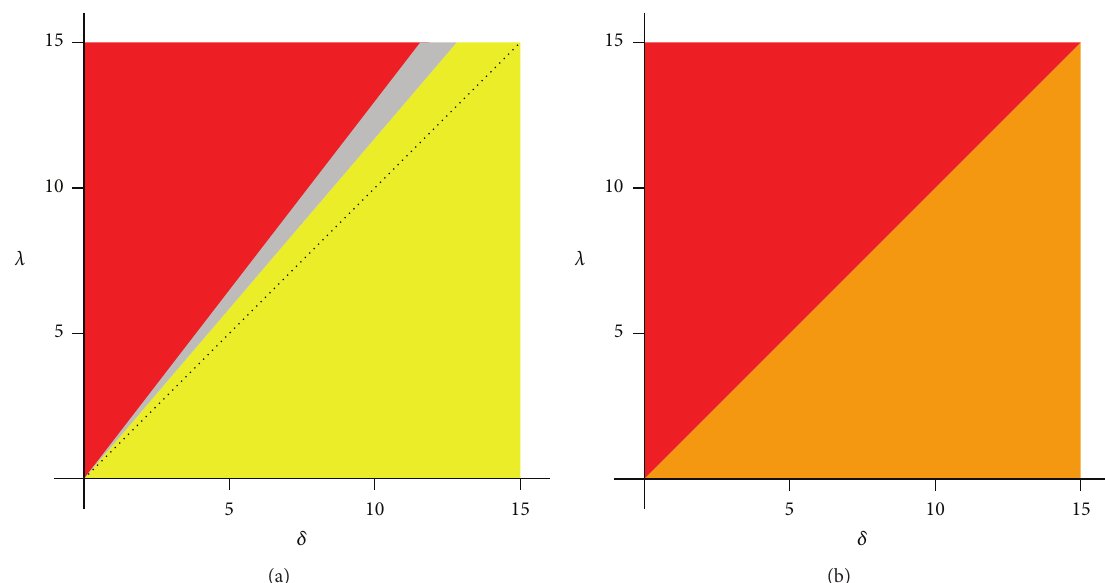
Figure 4: Possible epidemic outcomes. Yellow: disease-free. Orange: endemic primary infection. Gray: disease-free or endemic coinfection depending on initial values. Red: endemic coinfection. (a) Parameter values: 𝑎 𝑈 = 0 . 9 , 𝑎 𝑉 = 0 . 7 , 𝑟 = 26 , 𝑚 = 12 , 𝜇 𝑈 = 0 . 3 , 𝜇 𝑉 = 0 . 5 , 𝑐 𝑆𝑆 = 3 . 8 , = 0 . 5 , 𝑐 = 0 . 5 , 𝑐 = 2 . 6 , 𝑐 = 0 . 1 , 𝑐 = 1 , 𝑐 = 0 . 5 , 𝑐 = 4 , 𝑐 = 4 , 𝛽 = 4 , 𝛽 = 8 , 𝛾 = 0 . 2 . The parameter values in (b) are the 𝑐 𝑆𝑈 𝑆𝑉 𝑈𝑆 𝑈𝑈 𝑈𝑉 𝑉𝑆 𝑉𝑈 𝑉𝑉 𝑈 𝑉 same as before but 𝑚 = 17 , 𝑐 𝑆𝑆 = 2 . 8 , 𝛽 𝑉 = 4